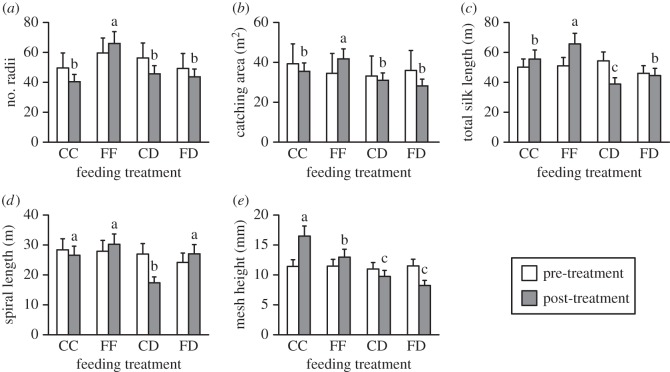
Pre-treatment (empty bars) compared with post-experiment (filled bars) values (mean±s.e.) for: (a) number of radii, (b) web catching area, (c) total silk length, (d) spiral length, and (e) mesh height for Nephila pilipes fed live crickets (CC), live flies (FF), dead crickets with the web stimulated by live flies (CD) or dead flies with the web stimulated by live crickets (FD). Letters show the results of Fisher's least significant difference post hoc analyses (a>b>c).